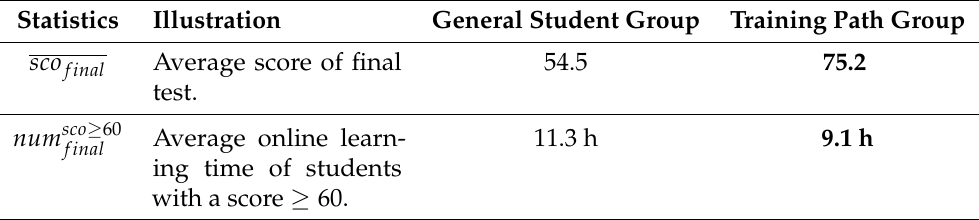
Table 3. Statistics of the average online learning time and the final test average scores of students. Statistics Illustration General Student